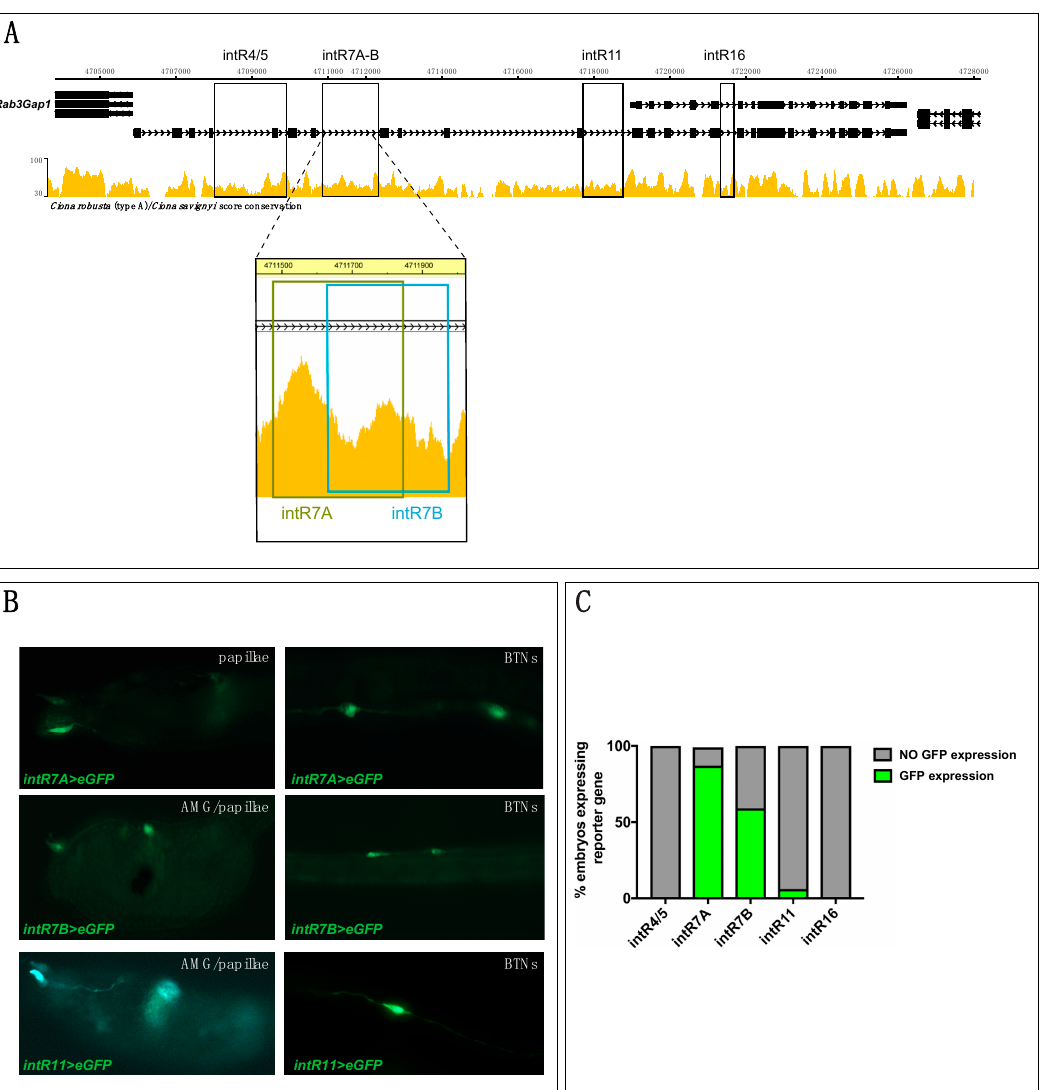
Figure 3. Intronic Cis -regulatory elements of Rimbp of Ciona robusta . ( A ) The genomic region comprising Rimbp and Rab3Gap1 with an automatic mVISTA plot between C. robusta and C. savignyi (ANISEED); rectangles indicate the intronic regions selected for cloning in eGFP vector ( intR4 / 5 , intR7 , intR11, intR16 ). Dashed lines show a higher magnification of the two distinct regions selected for the intR7 ( intR7A and intR7B ). ( B ) Expression of larvae electroporated with 70 micrograms of intR7A > eGFP, intR7B > eGFP, and intR11 > eGFP in di ff erent PNS territories of larva (st. 26) possibly including BTNs, papillae neurons, and AMGNs. ( C ) Percentages of larvae electroporated along with intR4 / 5 , intR7 , and intR11 , intR16 expressing with GFP in at least one type of cells of the nervous system. Each experiment was performed four times and at least 200 embryos were scored per each experiment.